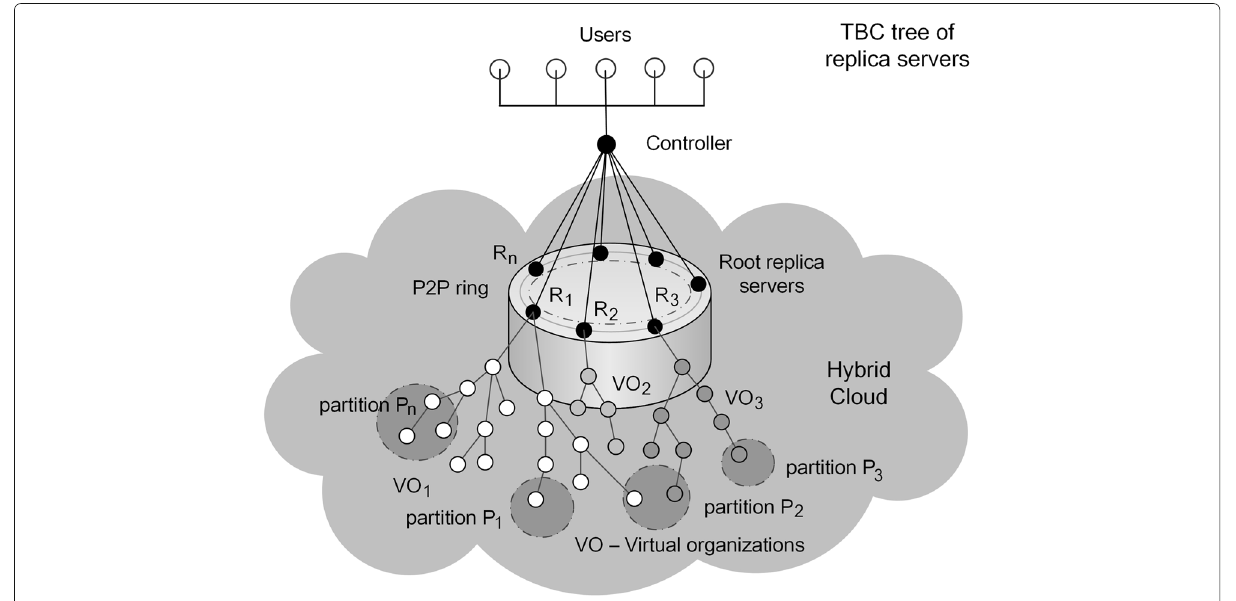
Fig. 9 The R-TBC tree structure of replica nodes for public companies or virtual organizations of the energy sector [21]